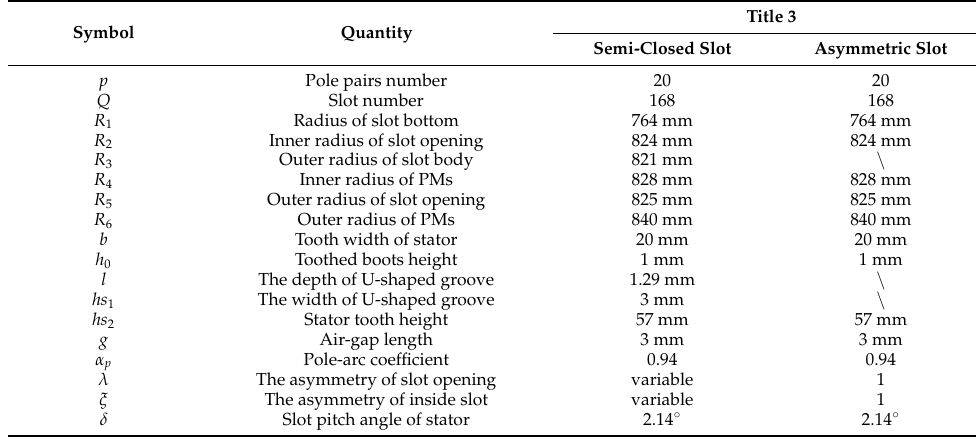
Figure 7. The FEM analysis of two LHPMSM prototype machines: ( a ) semi-closed slot; ( b ) asymmetric slot. Table 1. Main Geometric Dimensions of Prototype Machines.